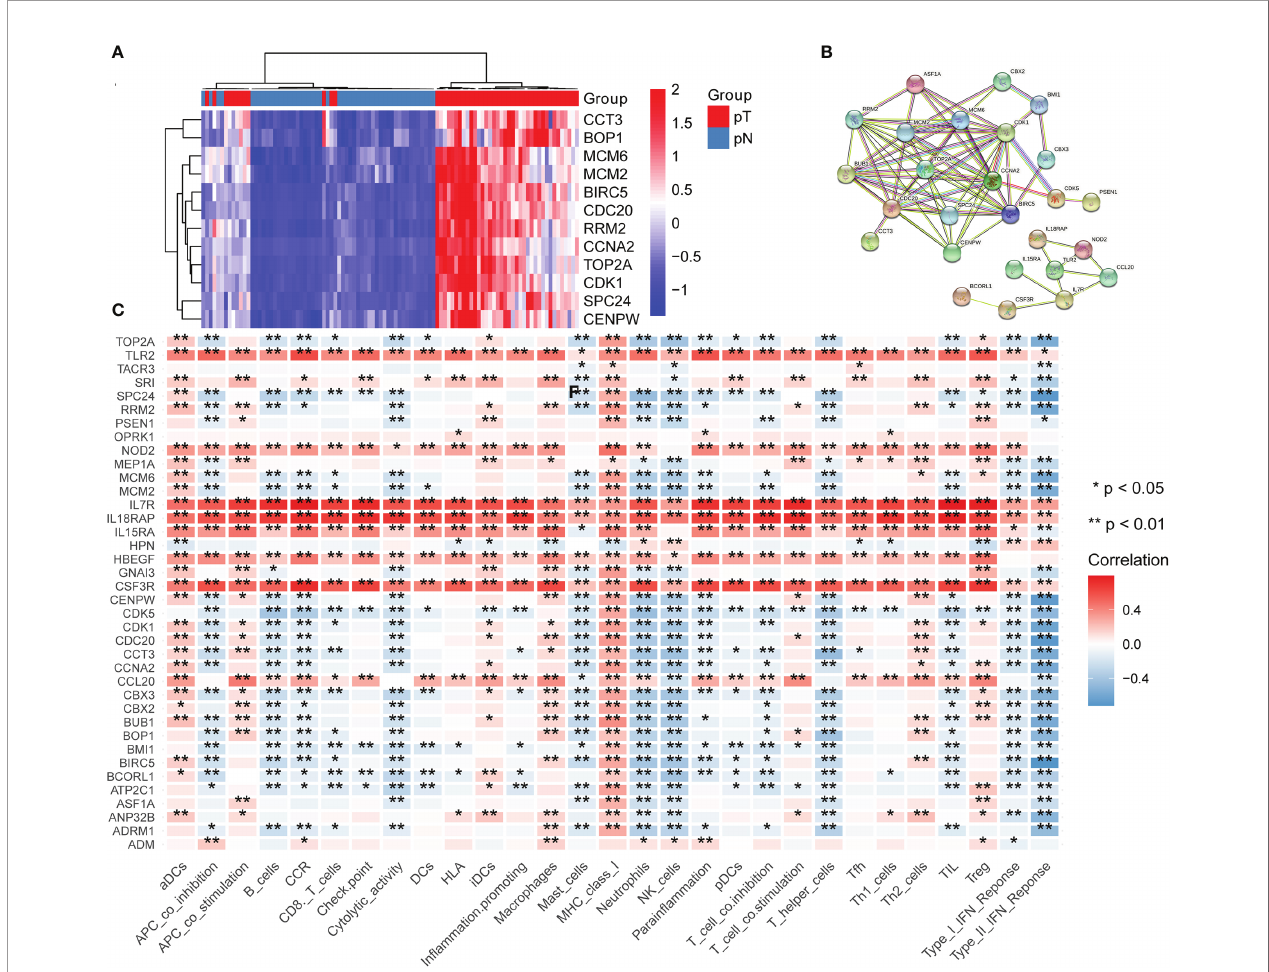
FIGURE 8 | The relationship between epigenetic-related genes, in fl ammatory response-related genes and CRISPR genes. (A) A heatmap showing the top 12 genes in CRISPR, pT: tumor, pN: normal; (B) A protein-protein interaction (PPI) network demonstrated that IRRGs PSEN1 was linked to most ERGs and CRISPR genes such as CDK1, TOP2A, CBX2, and CBX3 ; (C) The relationship between immune cells and these